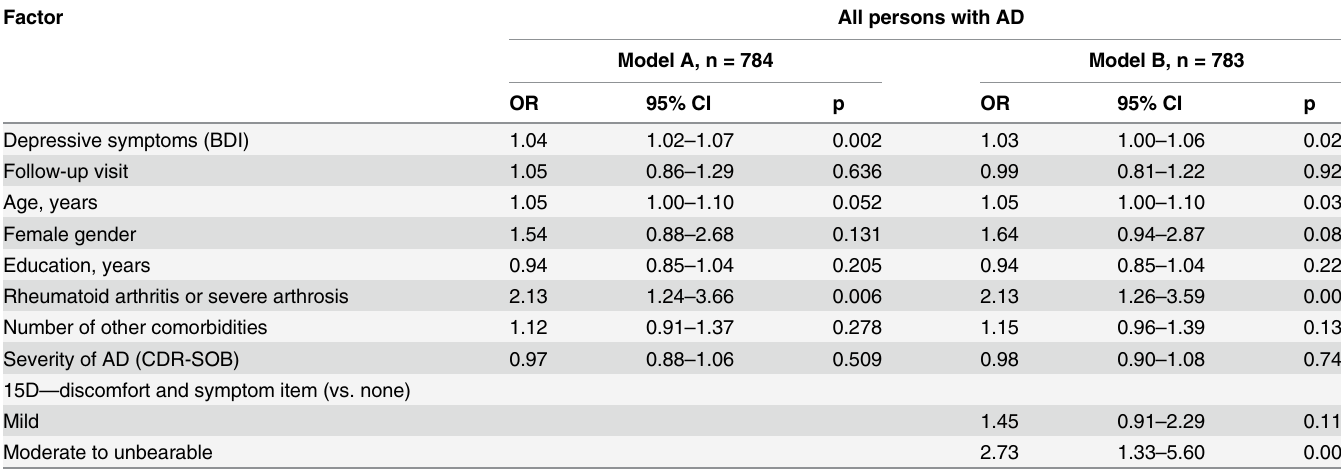
Table 4. Generalized Estimating Equation models (multivariate analyzes) exploring the impact of fi ve year patient factors on analgesic use over time (all persons with AD). Factor